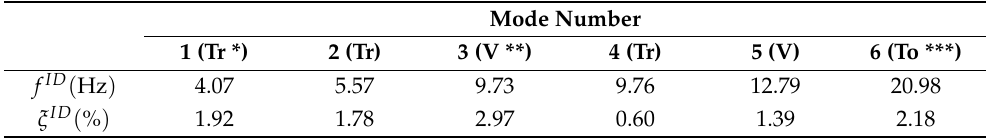
Figure 8. EFRFs calculated from the experimental data (blue) and EFRFs estimated using the identified state-space model (red): ( a ) Direction 3 and ( b ) Direction 1. Table 1. Identified natural frequencies and damping